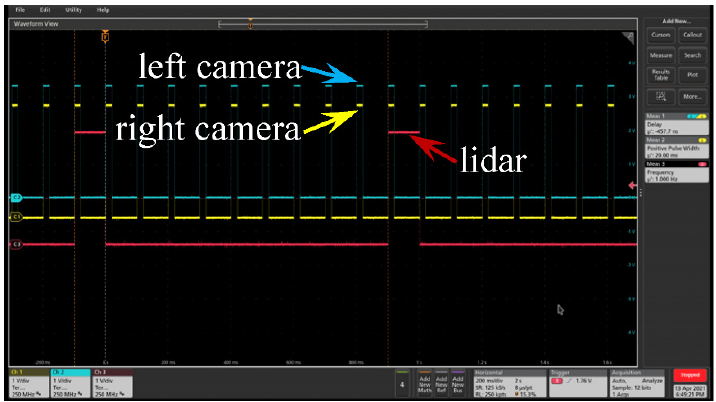
Figure 10. The stereo camera and LiDAR synchronization method. The trigger source signal received by the stereo camera and the LiDAR.